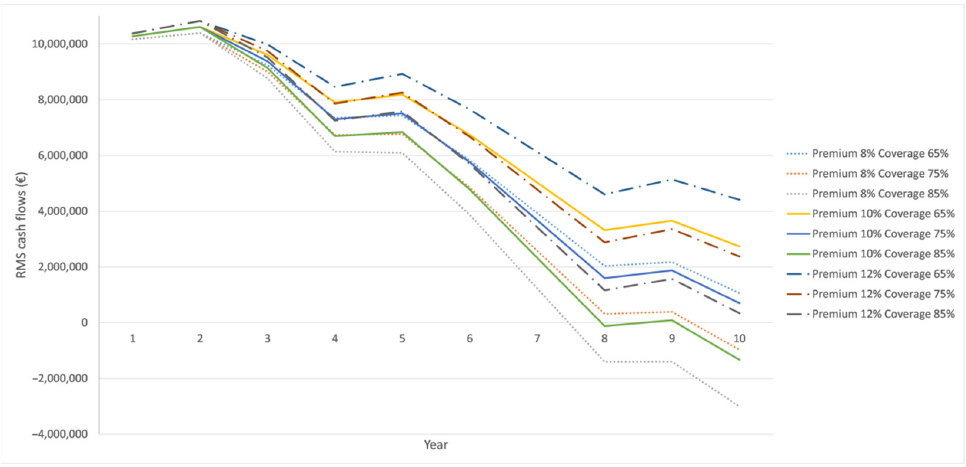
Figure 6. Simulation of RMS 10-year cash flows. Success rates: Scenario B; insurance premium: 8, 10, 12%; risk coverage: 65, 75, 85%.